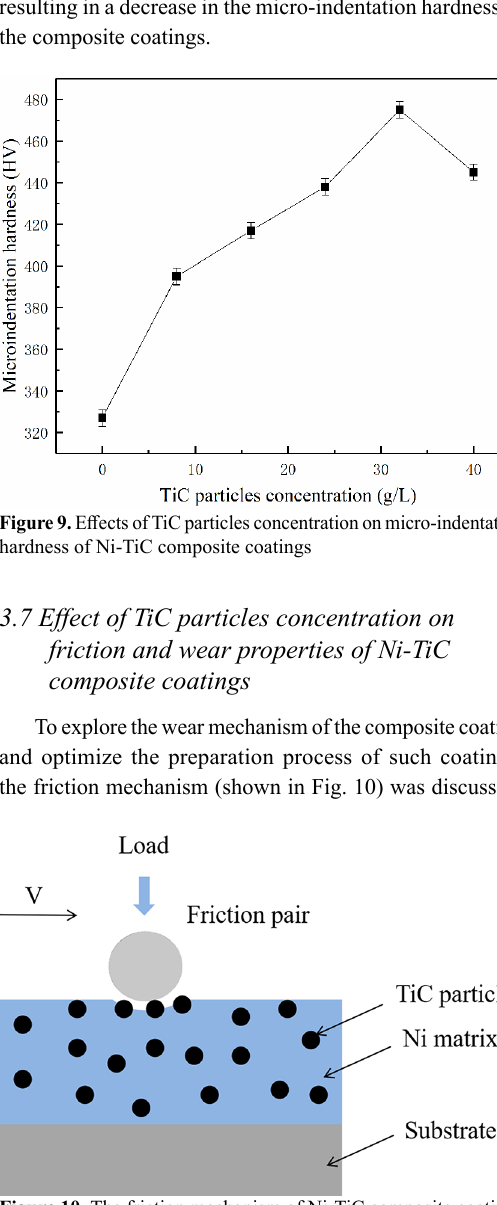
Figure 10. The friction mechanism of Ni-TiC composite